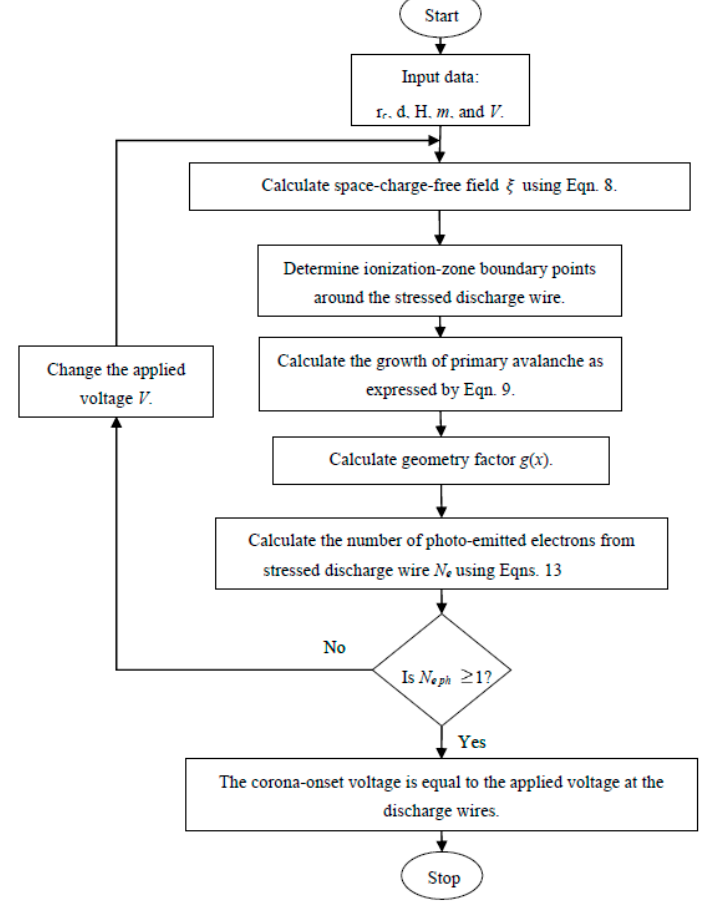
Figure 5. Flowchart of the calculation of the corona-onset voltage of WDESP.